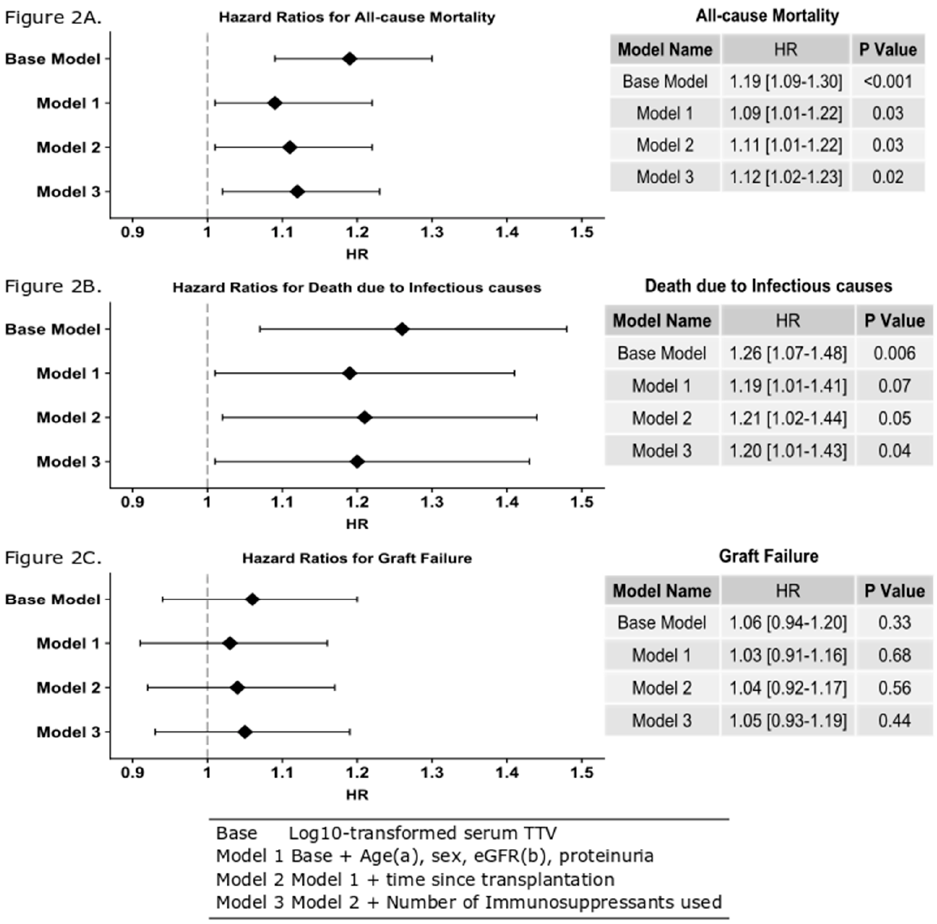
Figure 2. Hazard ratios calculated using Cox models and presented as a forest plot. ( A ) Log 10 TTV is predictive of all-cause mortality after adjustment for age, gender, eGFR proteinuria, time since transplant and the number of immunosuppressant’s used. This means that for each log increase in TTV, there is a 12% increase for a patient’s risk of death (HR 1.12 (95% CI 1.0.2–1.23), p = 0.02). ( B ) Log 10 TTV is predictive of death due to an infectious cause after adjustment for age, gender, eGFR proteinuria, time since transplant and the number of immunosuppressant’s used. This means that for each log increase in TTV, there is a 20% increase for a patient’s risk of death (HR 1.20 (95% CI 1.01–1.43), p = 0.04). ( C ) Log 10 TTV is not predictive of graft failure after adjustment for age, gender, eGFR, proteinuria, time since transplant and the number of immunosuppressant’s used. a Categorical variable used for death due to an infectious cause. b Categorical variable used for all-cause mortality and graft failure.